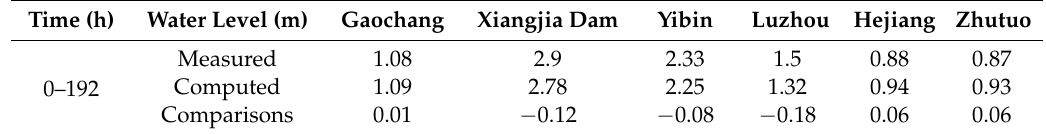
Table 3. Flood wave height and comparisons on 20–27 October